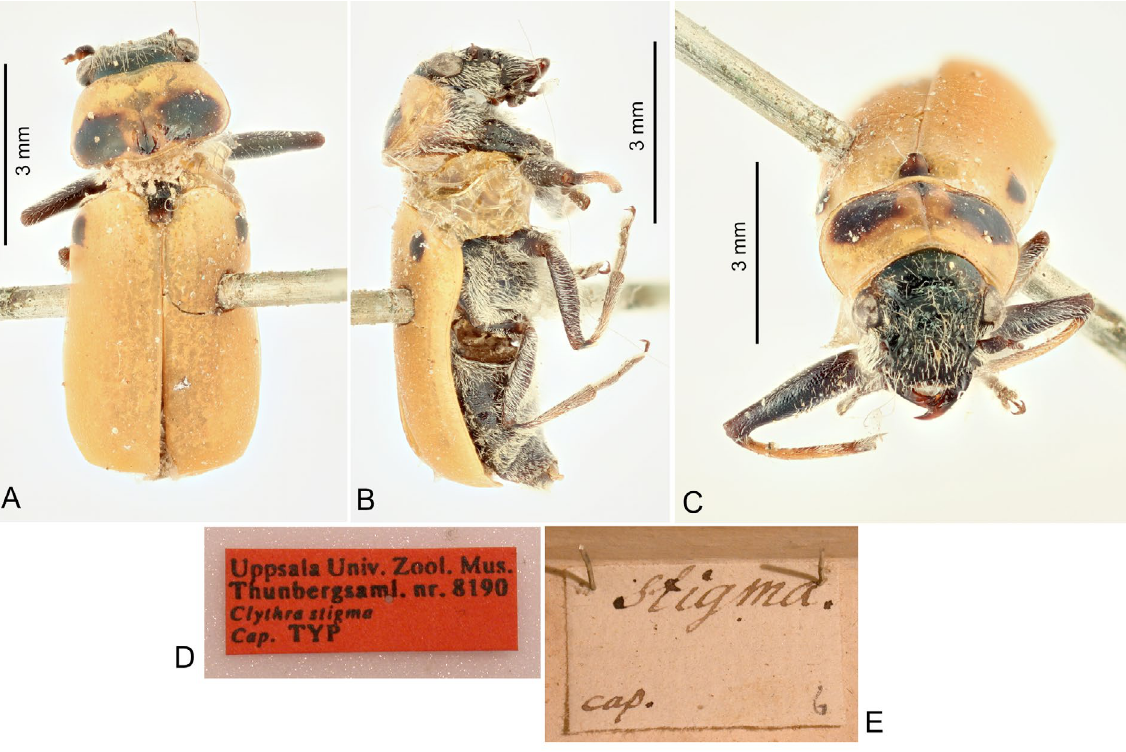
Fig. 8. Miopristis stigma (Thunberg, 1821), holotype, ♂, 7.0 mm, UUZM. A . Dorsal view. B . Lateral view. C . Frontal view. D . Label. E . Box